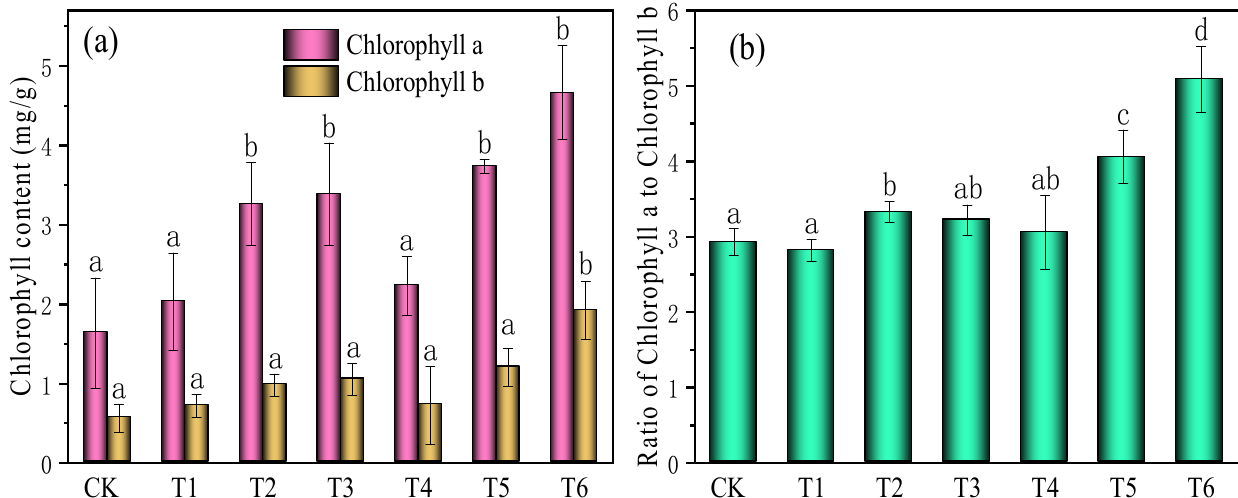
Figure 4. Effects of different treatments on chlorophyll content ( a ) and ratio of chlorophyll a to chlorophyll b ( b ) of tomato. Data with different letters are significantly different ( p < 0.05).